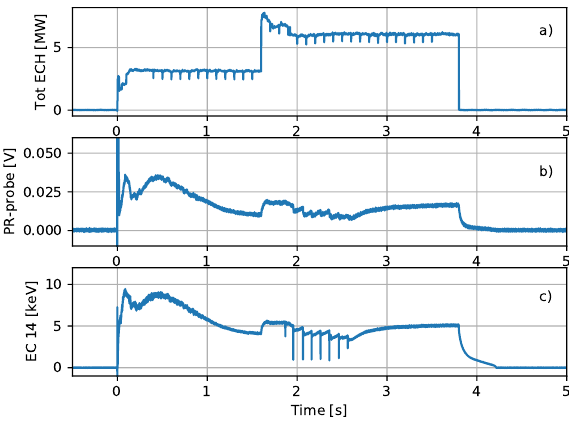
Figure 4: ECE finger-print on Profile Reflectometer stray radiation probe (b) using the data as in Fig. 3.